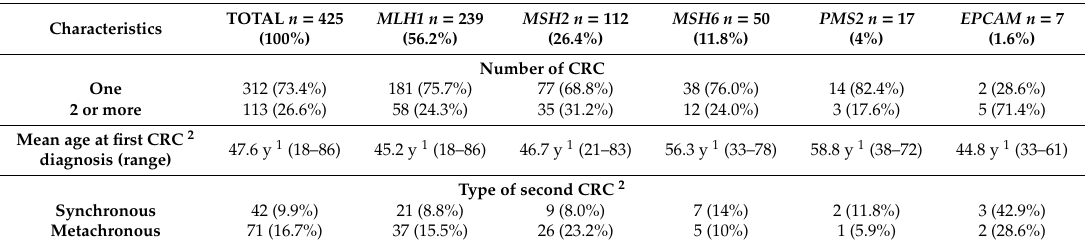
Table 2. Number of colorectal cancer and type of second colorectal cancer according to mutated genes. Characteristics